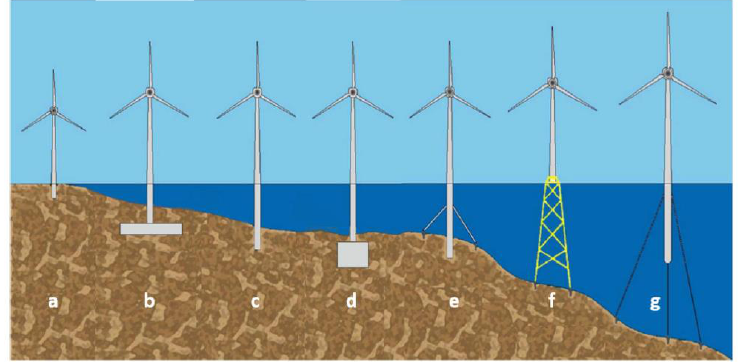
Figure 3. Wind turbine foundation types (adapted from [17] with permission from Elsevier, 2018): ( a ) onshore foundation, ( b ) gravity foundation, ( c ) monopile foundation, ( d ) Suction bucket foundation, ( e ) tripod foundation, ( f ) jacket foundation, ( g ) floating foundation.